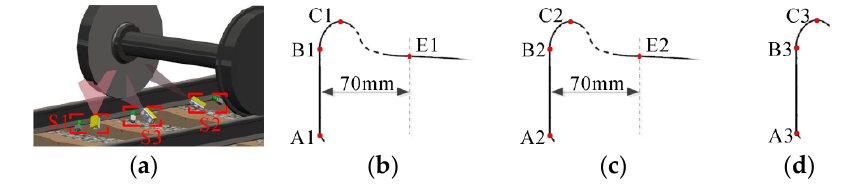
Figure 8. The wheel tread measurement. ( a ) The sensors for tread measurement; ( b ) the result of S1; ( c ) the result of S2; ( d ) the result of S3.